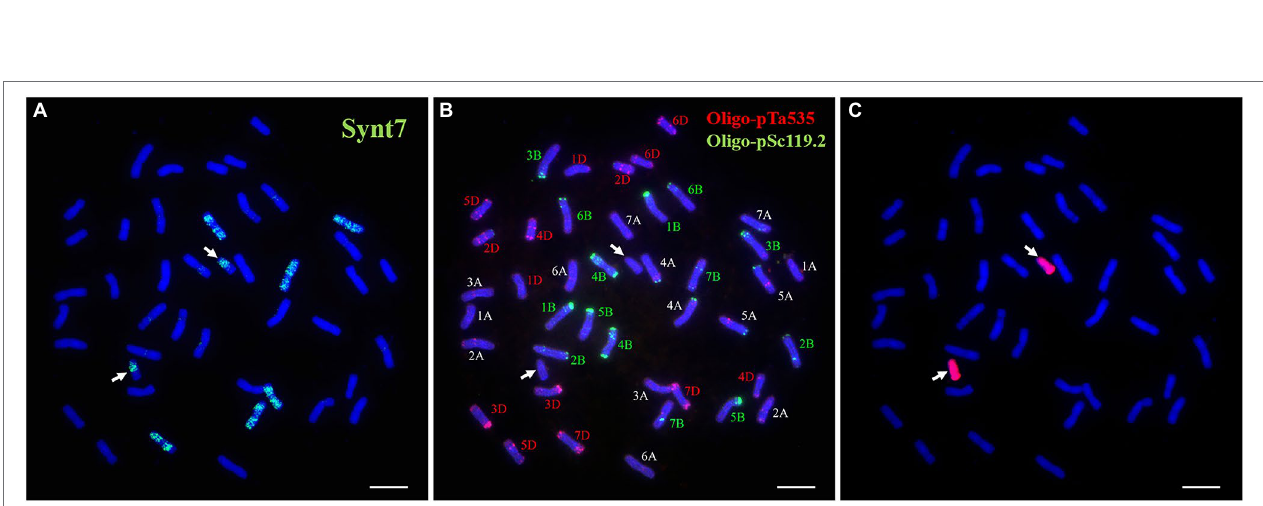
FIGURE 1 | FISH and sequential GISH identification of the wheat- P. huashanica ditelosomic addition line DT23. (A) FISH identification of DT23 using Oligo-pSc119.2 (green) and Oligo-pTa535(red). (B) Sequential GISH analysis on the same metaphase cell of DT23 using P. huashanica genomic DNA as a probe (red). (C) GISH identification of the selfed progeny of DT23 which carried a pair of Ns telocentric chromosomes. (D) GISH identification of the selfed progeny of DT23 which carried one Ns telocentric chromosome. Arrows indicate the introduced P. huashanica chromosomes in DT23. Scale bar: 10 μ m.